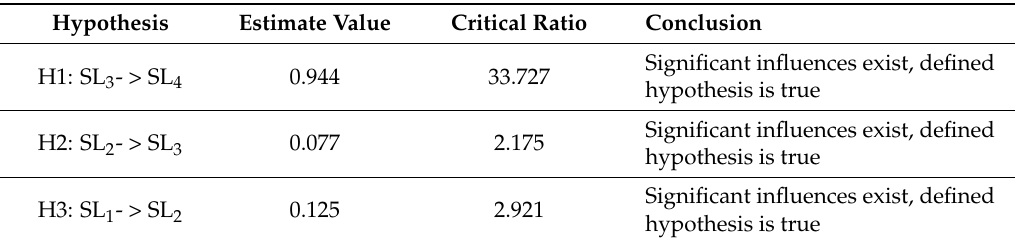
Table 5. Data of the critical ratio of variables.